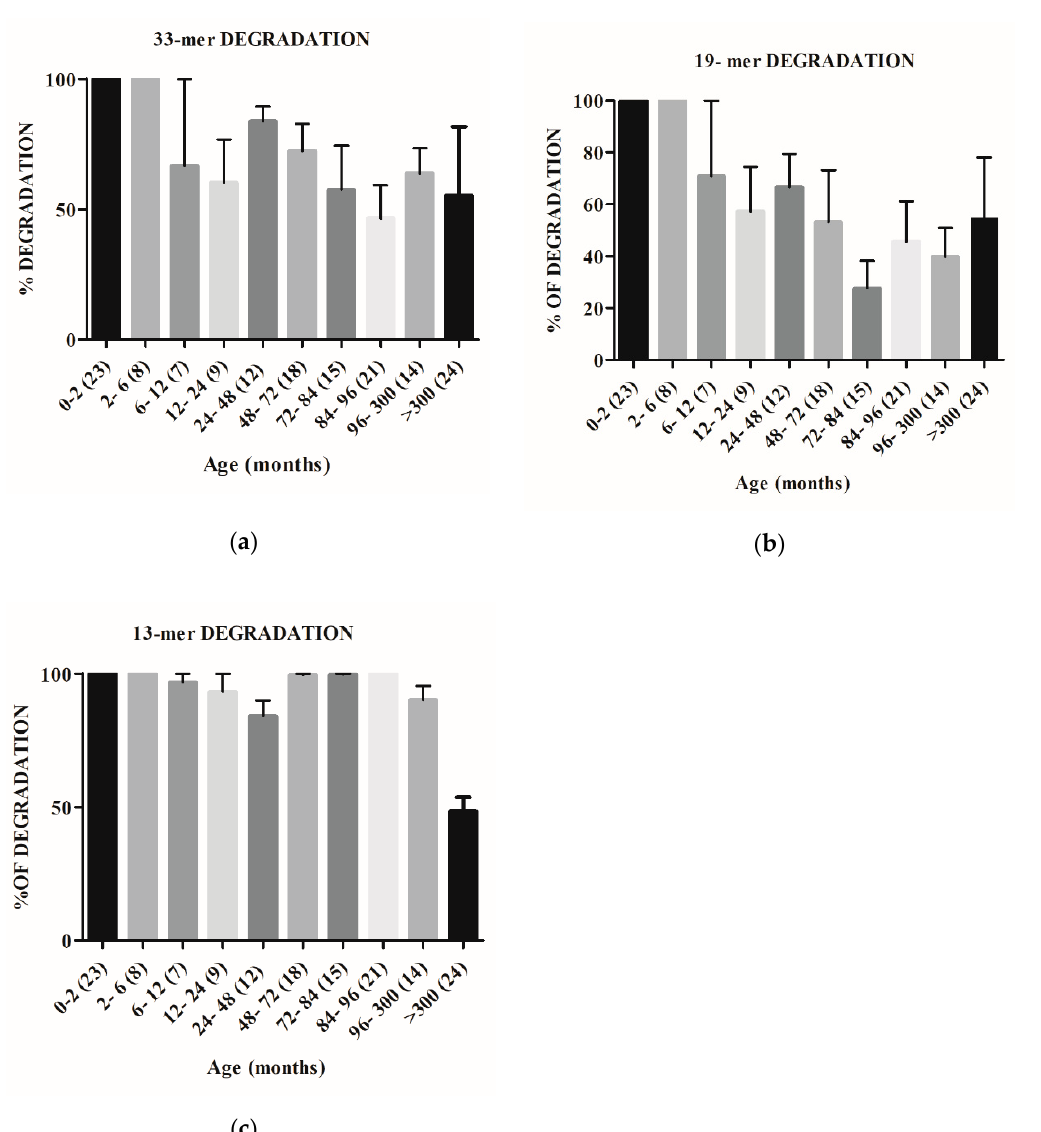
Figure 4. Fecal hydrolytic activity against gliadin peptides derived from samples from different age range volunteers. HPLC chromatograms generated after incubating the 33-, 19-, and 13-mer peptides for 60 min at 37°C with desalted fecal protein extracts were used to evaluate the peptide degradative capacity (in%). The results are grouped by age ranges of samples. Brackets reflect the number of volunteers of each age group. Interaction of age with degradation of immunogenic gluten-derived peptides is shown by two way ANOVA. ( a ) p = 0.2128; ( b ) p = 0.0905; ( c ) p = 0.0001.